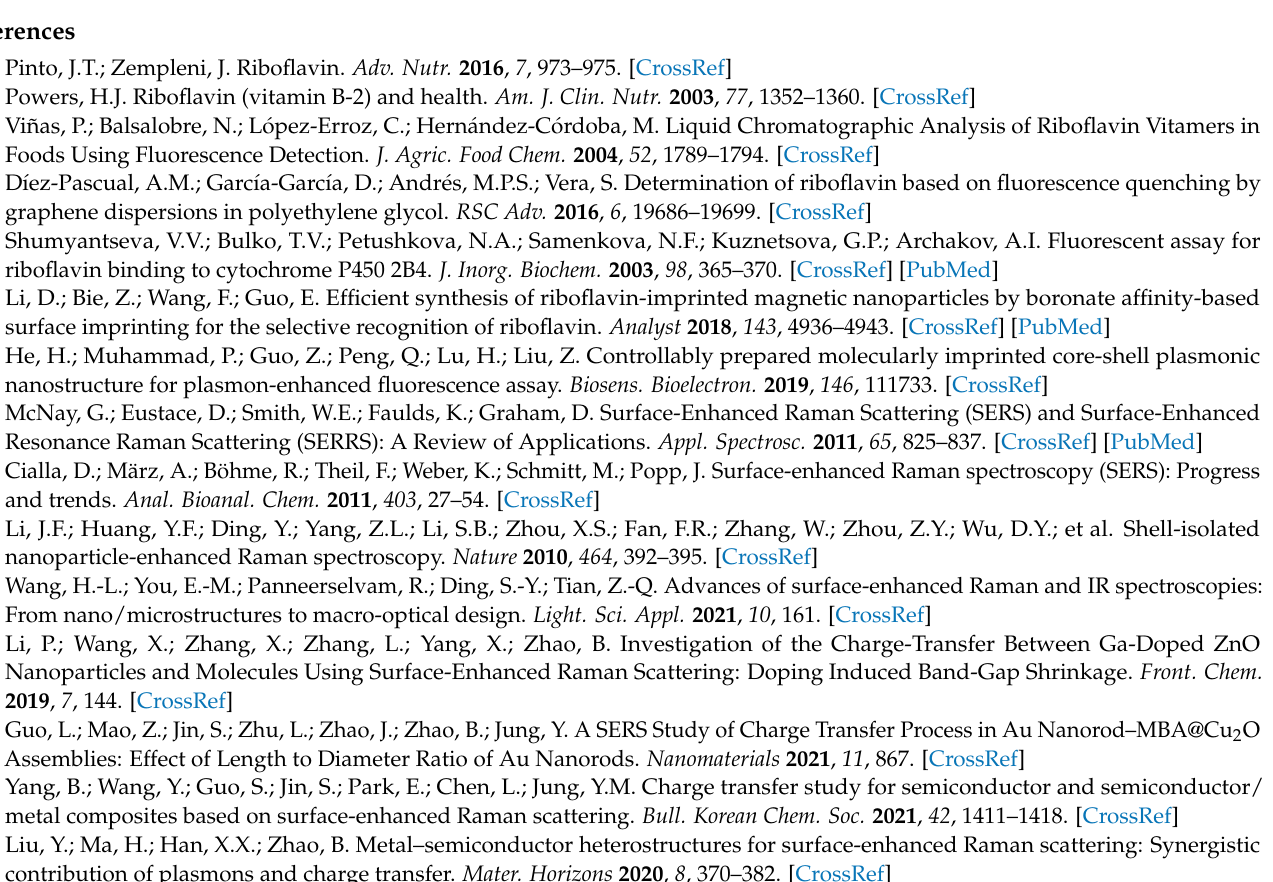
532 nm laser; Figure S7: 532 nm laser Raman spectra of RF( A ) and FMN ( B ), mixed with the same concentration of adenine or ATP; Figure S8: 532 nm laser Raman spectra of adenine replaced by RF ( A ) and FMN ( B ) on Ag films, respectively; Table S1: Band assignments of Raman and SERS